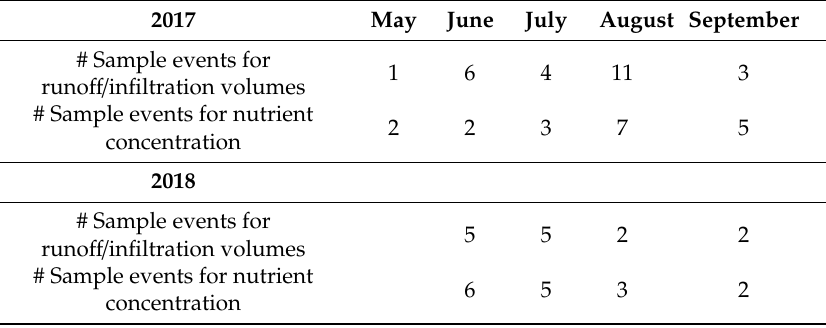
Table 1. Number of sample events by month for runo ff and infiltration volume and nutrient concentration in 2017 and